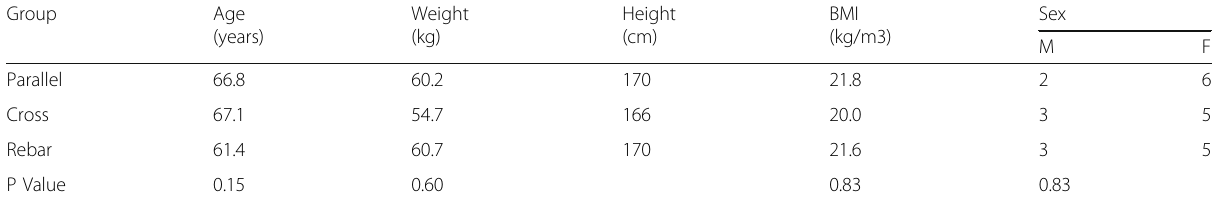
Table 1 Demographic data of cadaver